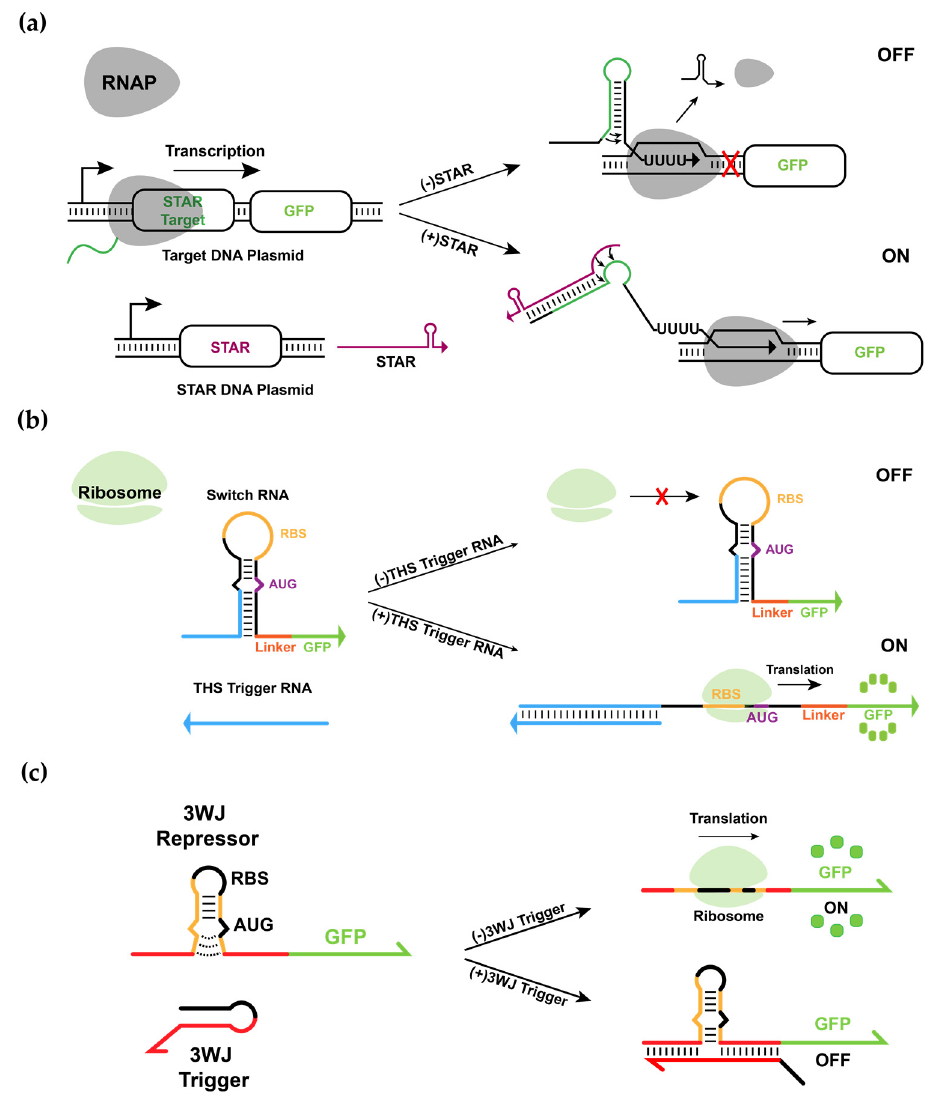
Figure 1. De novo-designed synthetic RNA regulators, STAR, THS and 3WJ repressor. ( a ) Schematic of the STAR mechanism. The target RNA folds into a rho-independent transcription terminator that causes RNA polymerase (RNAP) to halt transcription. When STAR binds to the target RNA, terminator formation is prevented, allowing transcription elongation of the gene. ( b ) Schematic of the THS mechanism. The ribosomal binding site (RBS) and start codon (AUG) of the switch RNA are exposed only when the cognate trigger RNA disrupts the secondary structure. ( c ) The switch RNA of a 3WJ repressor contains an unstable hairpin structure that allows ribosomal access to the RBS and start codon and toehold domains for 3WJ trigger binding. The 3WJ trigger RNA employs a toehold to bind to the 3WJ repressor RNA, forming a 3WJ structure that prevents translation initia- tion.